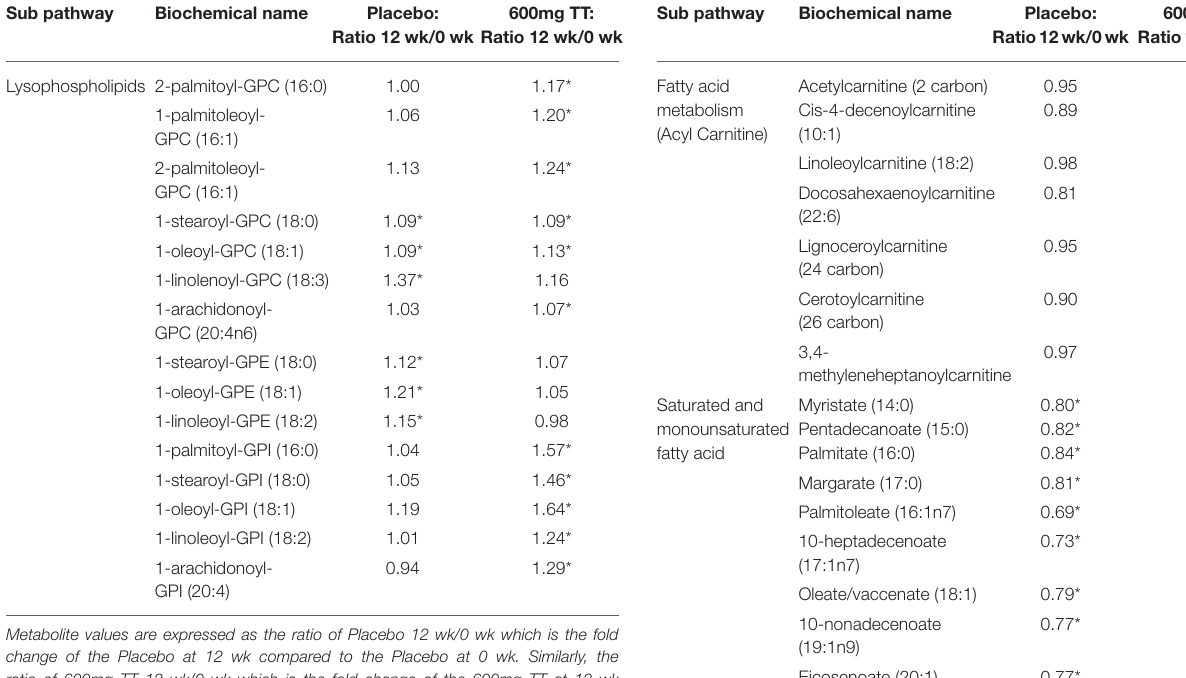
TABLE 6 | Changes in metabolites associated fatty acids in serum of the Placebo and the 600mg TT groups at 0 and 12 wk. Sub pathway Biochemical